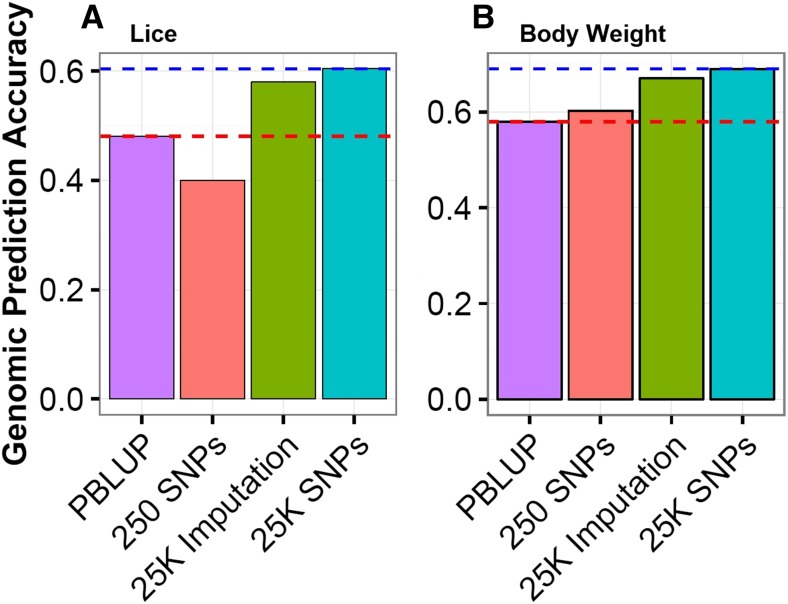
Breeding value prediction accuracies for (A) sea lice resistance and (B) body weight calculated using (i) the pedigree (PBLUP), compared to genomic prediction using (ii) the 256 SNP LD panel only, (iii) the 256 SNP LD panel imputed to 25 K SNPs (with all parents and 25% offspring genotyped at MD SNP panel), and (iv) the true genotypes for the 25 K MD SNP panel. For comparison, the accuracy of breeding value prediction under scenario (iv) is shown by the blue dashed line, and the corresponding accuracy under scenario (i) with the red dashed line.